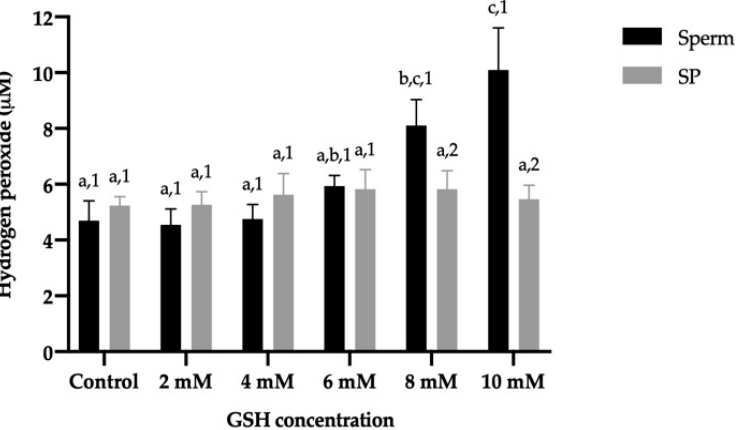
Figure 3. Mean ± SEM of extracellular hydrogen peroxide (H 2 O 2 ) produced by donkey sperm and seminal plasma (SP) exposed to reductive stress with increasing reduced glutathione (GSH) concentrations at 37 °C for 30 min. (a–c) Different letters indicate significant differences ( p ≤ 0.05) between GSH concentrations in sperm or SP. (1,2) Different numbers indicate significant differences ( p ≤ 0.05) between sperm or SP within a given GSH concentration.